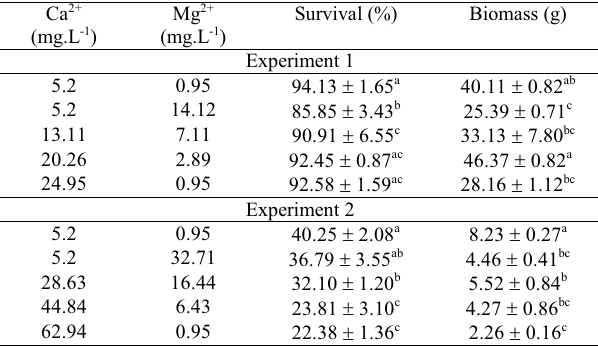
Table 2 . Survival and biomass of silver catfish larvae after 21 days as a function of Ca 2+ and Mg 2+ concentrations in the water. Means (±SEM) with different letters in the same col- umn and experiment are significantly different (P < 0.05) as determined by ANOVA and by the Tukey test. First line of each experiment is the treatment with water hardness of 20 mg.L -1 CaCO 3